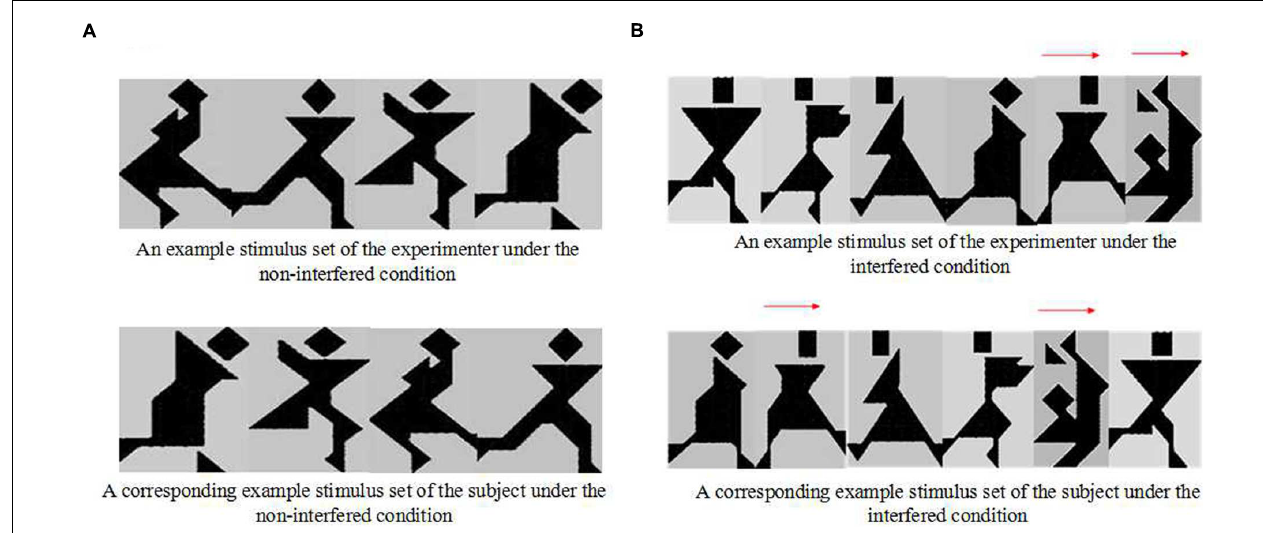
FIGURE 1 | The materials for (A) the non-interfered condition and (B) the interfered condition in Experiment 1.